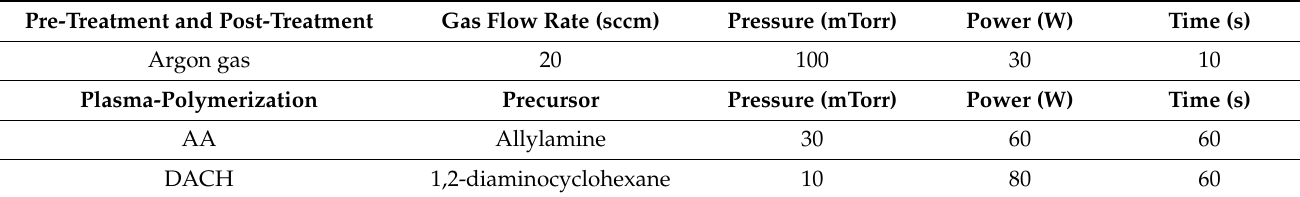
Table 1. Plasma-polymerization